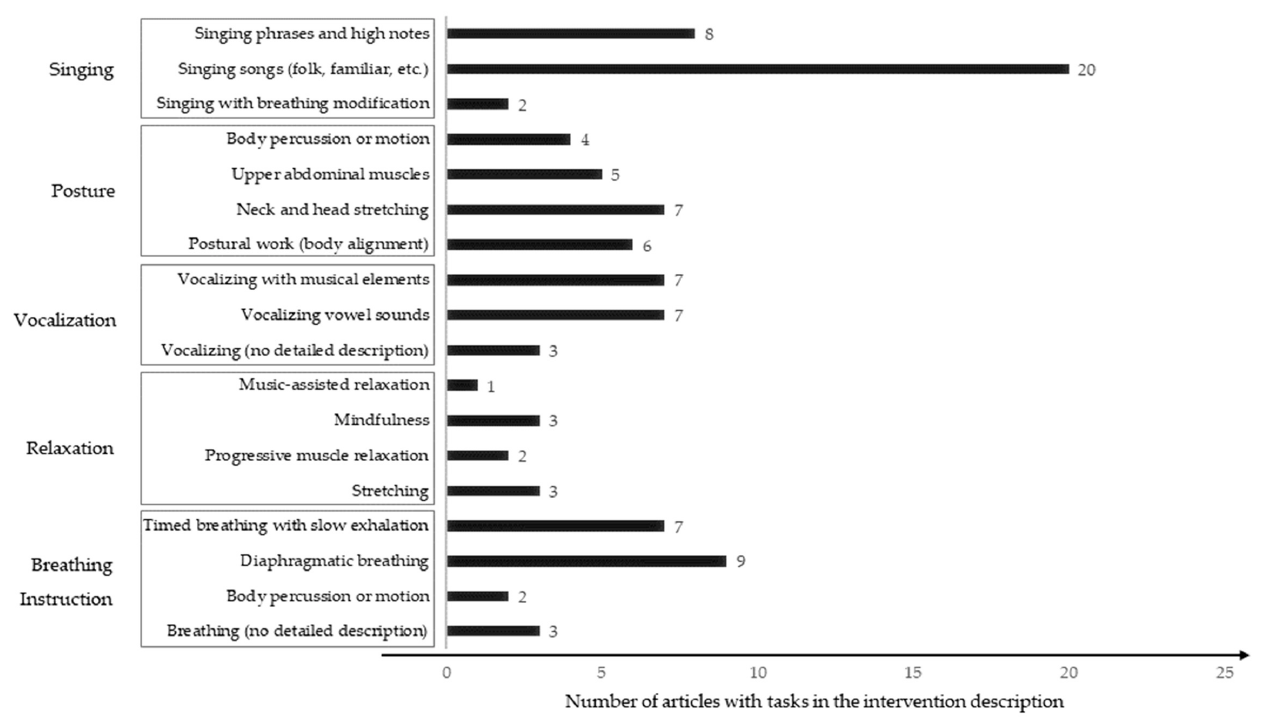
Figure 2. Singing-related activities described in the intervention procedure.